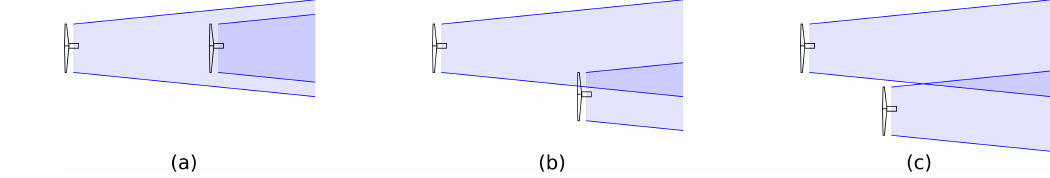
Figure 1. Different cases of merging wakes: (a) aligned wakes, (b) wake–turbine interaction and (c) wake–wake interaction.